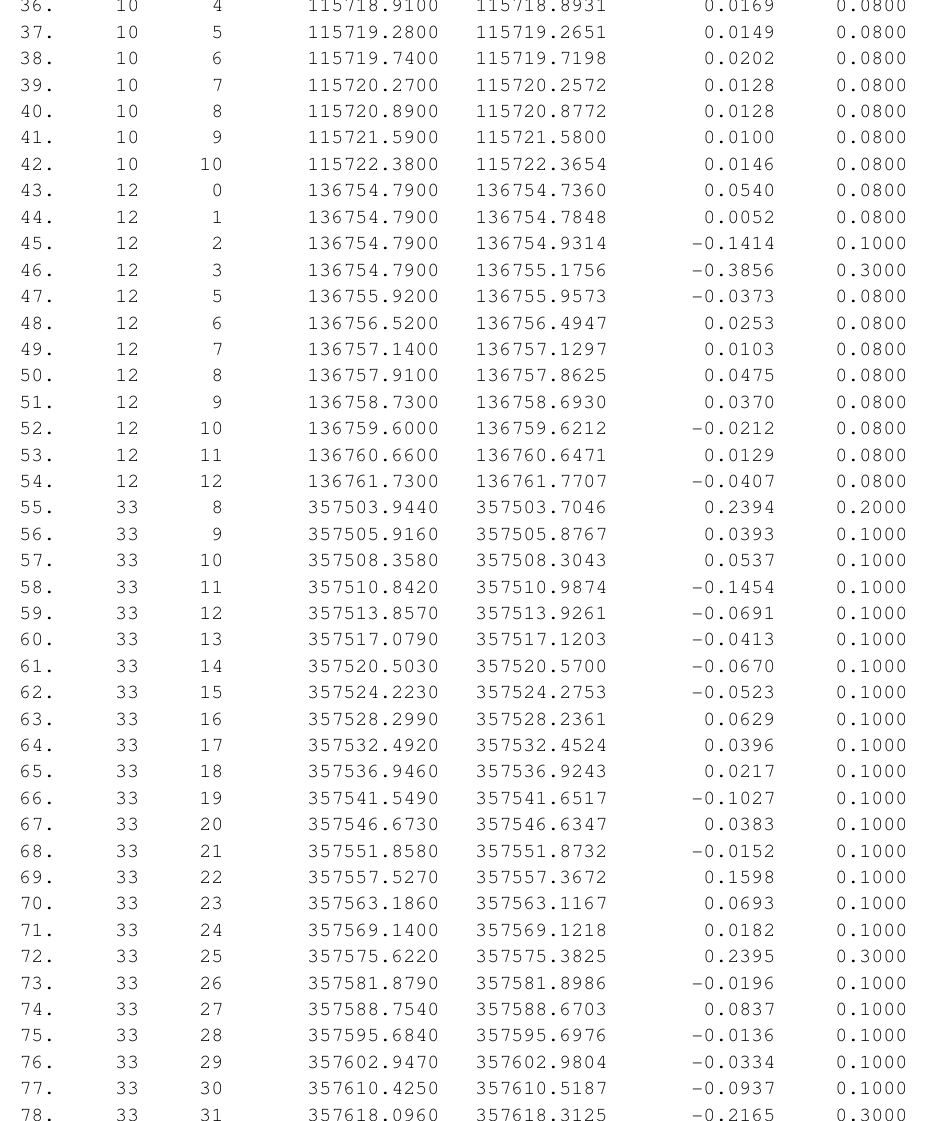
Table 4. Correlation coefficients of obtained parameters for (CH